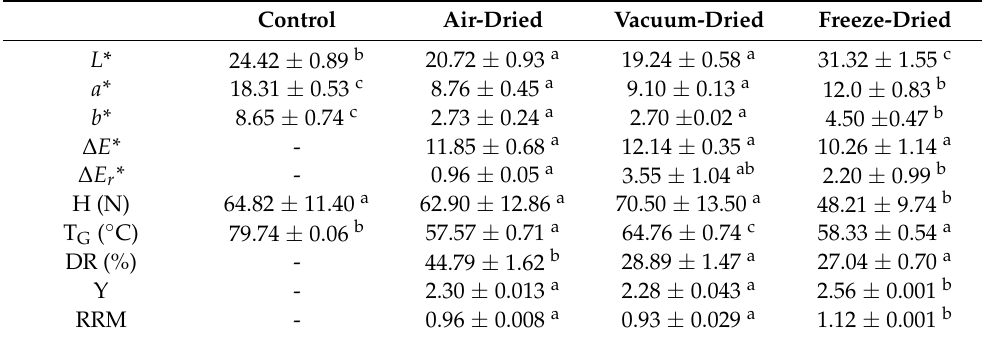
Table 2. Color parameters ( L *, a *, b * and ∆ E *), temperature of gelatinization/melting (T G ) and degree of retrogradation (DR%) of dried beans, and color change ( ∆ E r *), hardness (N), Y and RRM of rehydrated beans (mean ± standard deviation) 1 .